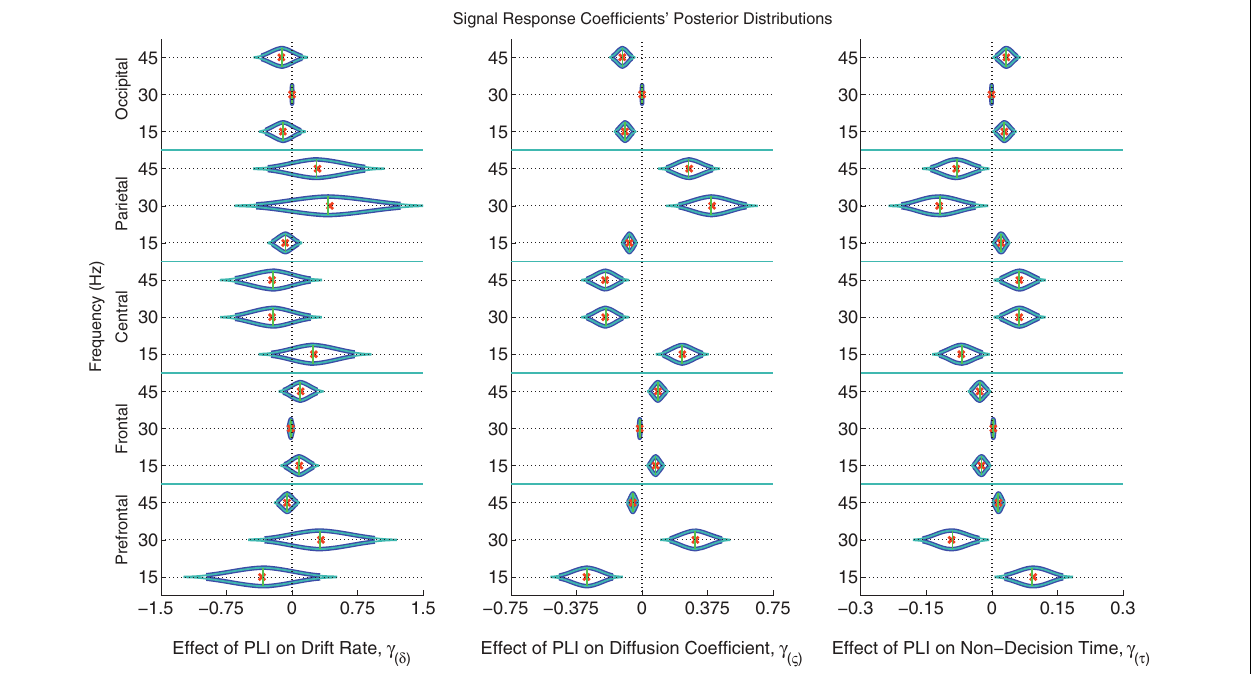
FIGURE 6 | The marginal posterior distributions of the signal PLI coefficients. I.e., the effects of signal enhancement, as measured by a steady-state phase-locking index (PLI), on the evidence accumulation rate (drift rate; in evidence units per second), variance in the evidence accumulation process (the diffusion coefficient; in evidence units per second), and non-decision time during the response interval (in seconds). Dark blue posterior density lines indicate 95% credible intervals while smaller teal lines indicate 99% credible intervals. Small horizontal green lines embedded in density curves indicate the median of the posterior